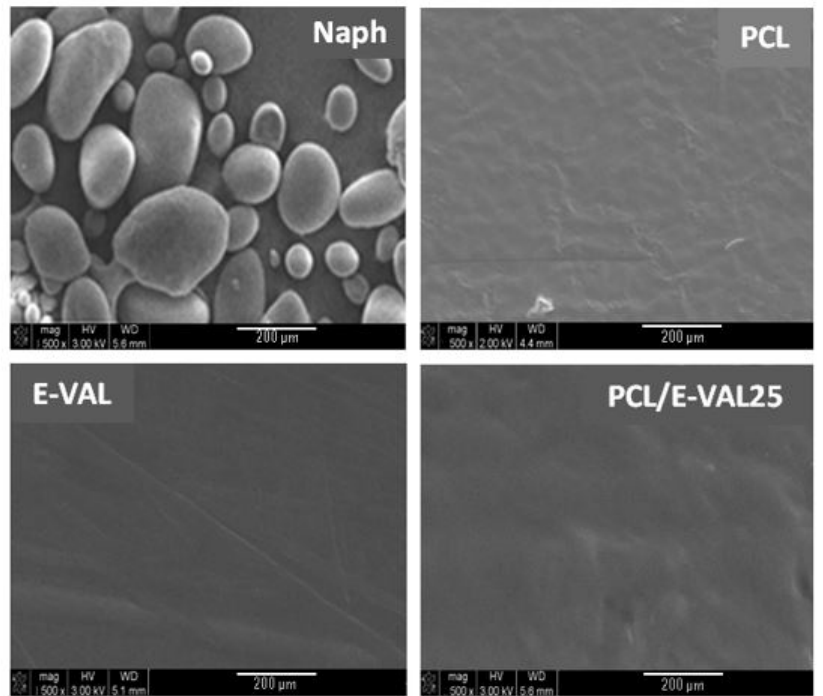
Figure 11. SEM micrographs of Naph microparticles and surface morphologies of PCL, E-VAL and PCL/E-VOH25 films.